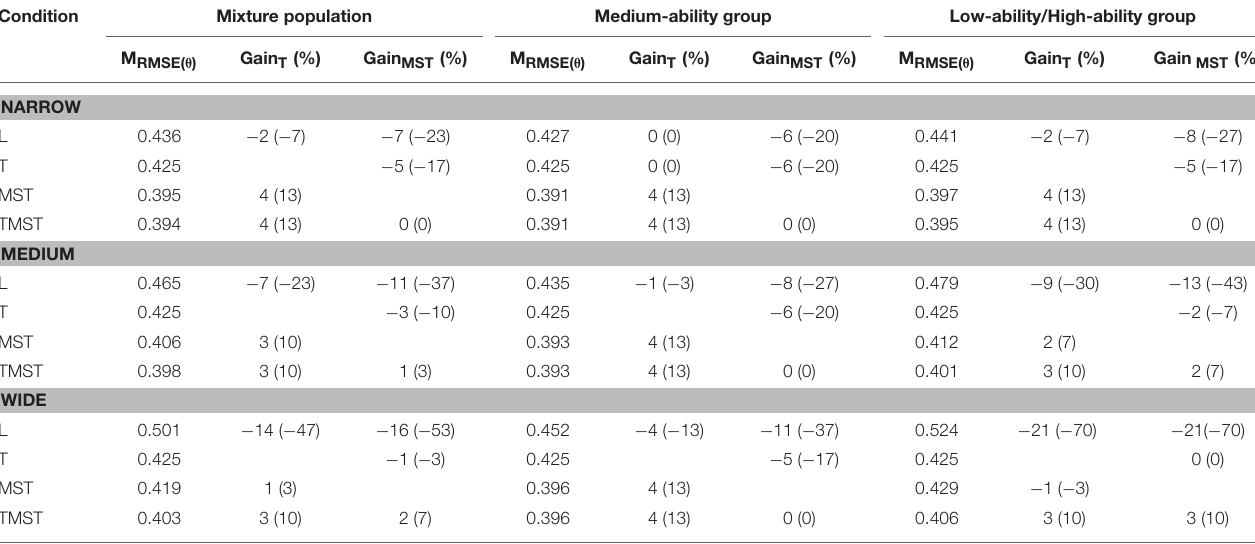
TABLE 4 | Mean RMSE( ˆ θ ) and relative gain over targeted and MST designs per distribution condition and ability group.